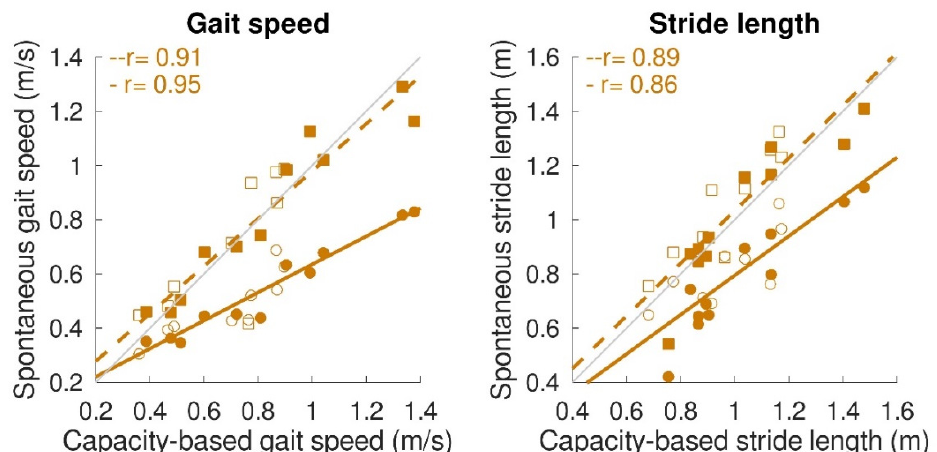
Figure 6. Relation between gait capacity and gait performance (spontaneous gait characteristics). Maximum spontaneous and average spontaneous gait speed ( left panel ) and maximum spontaneous and average spontaneous stride length ( right panel ) were significantly correlated with capacity-based gait speed and capacity-based stride length, respectively. Circular dots with solid regression lines represent the average spontaneous gait characteristic, while square dots with the dashed regression lines represent the maximum spontaneous gait characteristic. A single participant is represented by a filled dot for stroke patients and an open dot for iSCI patients. Grey lines represent perfect fit (x = y), whereas the orange lines represent the regression lines.